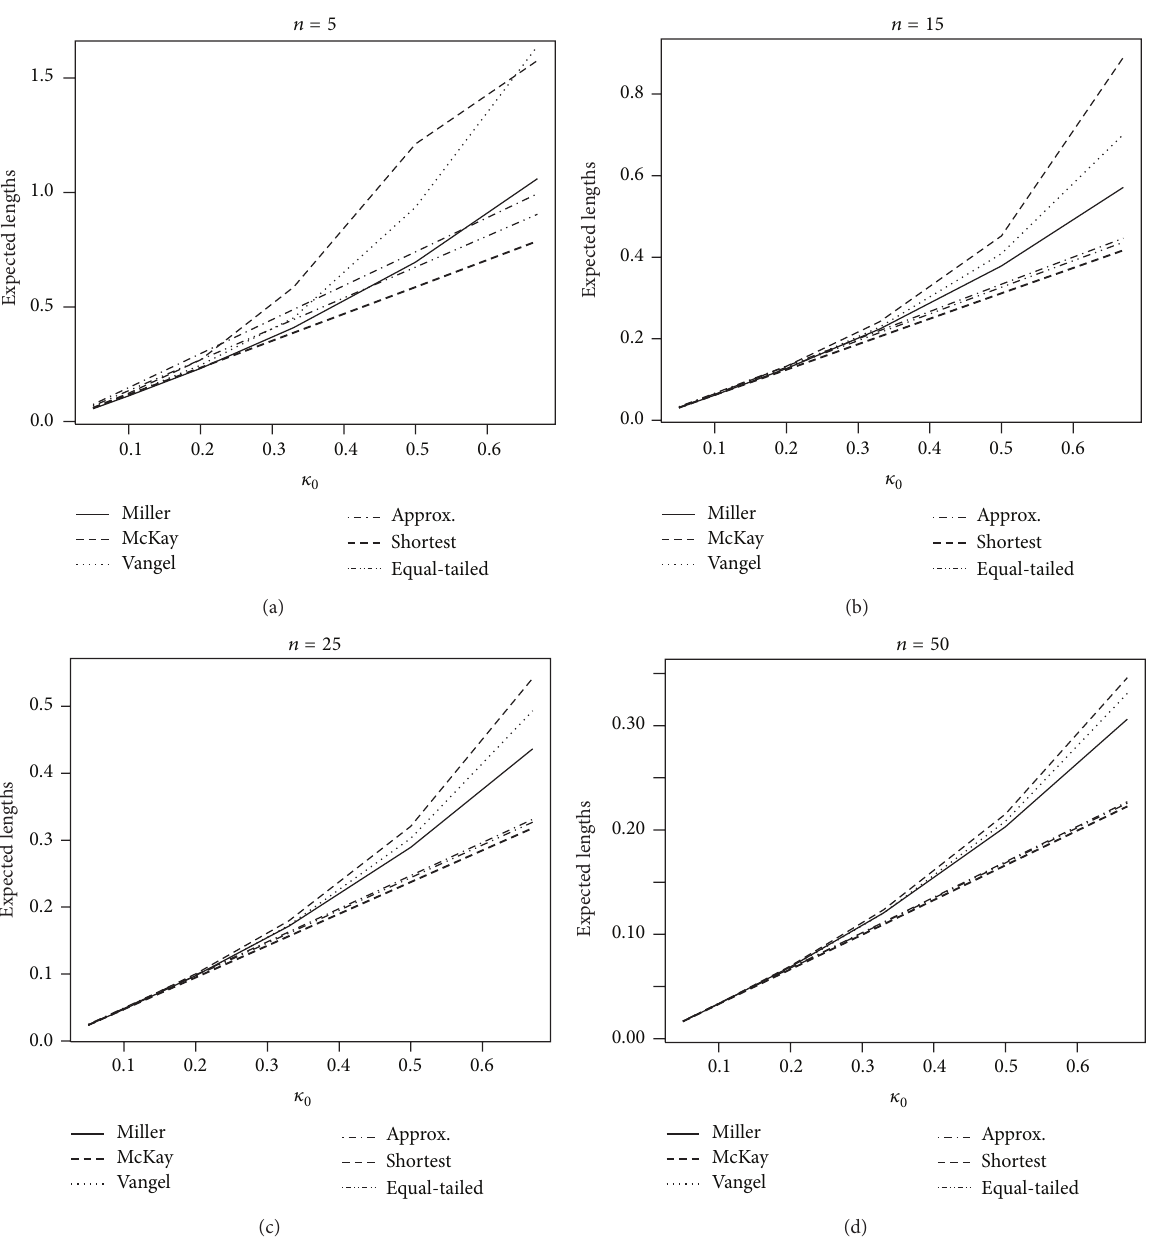
Figure 2: The expected lengths of 90% confidence intervals for the coefficient of variation in a normal distribution with a known population